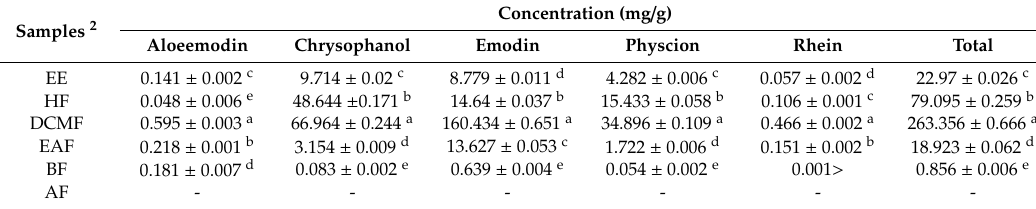
Table 2. Anthraquinone derivative contents of Rumex crispus L. root extracts and fractions 1 . Samples